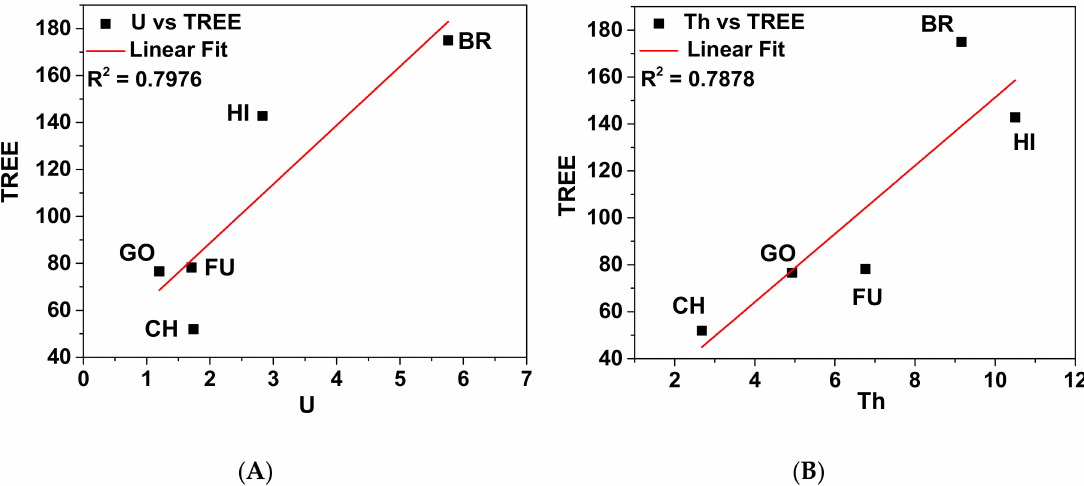
Figure 4. Correlation between ( A ) concentrations of U ( µ g / g) and TREEs ( µ g / g) and ( B ) concentrations of Th ( µ g / g) and TREEs ( µ g / g) for di ff erent soils (BR—Bratoselce, CH—Chernobyl, FU—Fukushima, GO—Gomel,